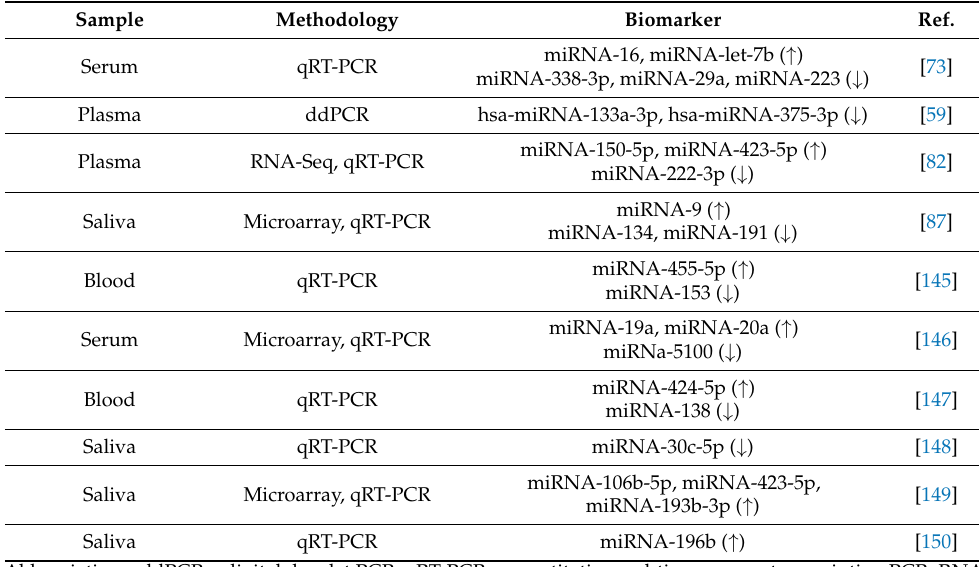
Table 1. The circulating miRNAs for the early diagnosis and surveillance of oral cancer.